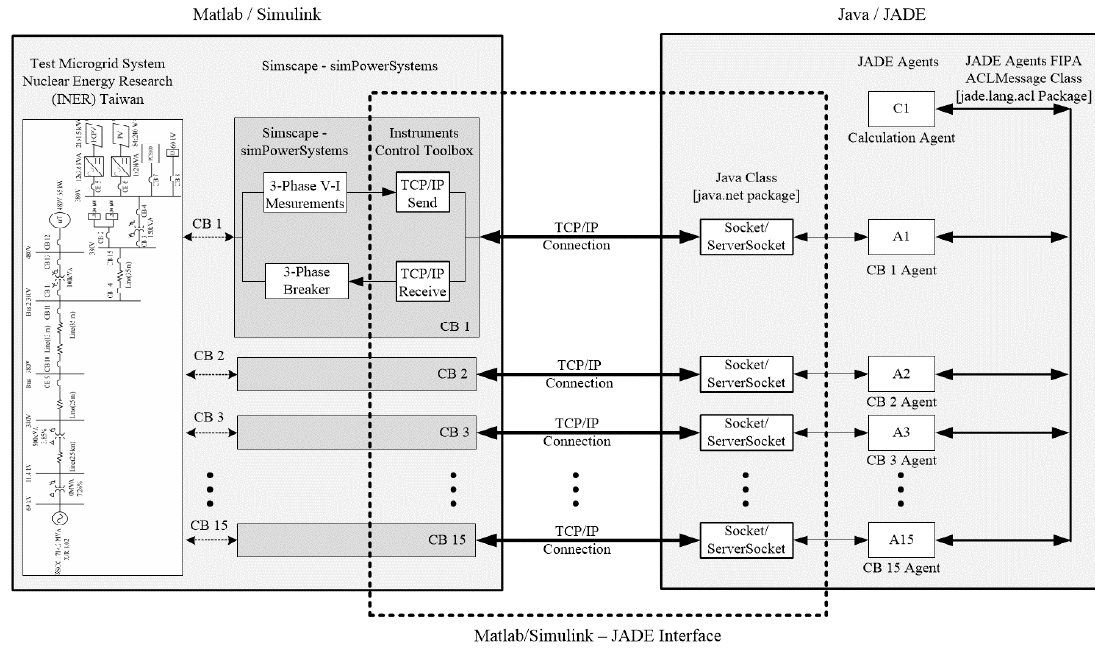
Figure 5. Diagram of the interface between Matlab/Simulink and JADE.